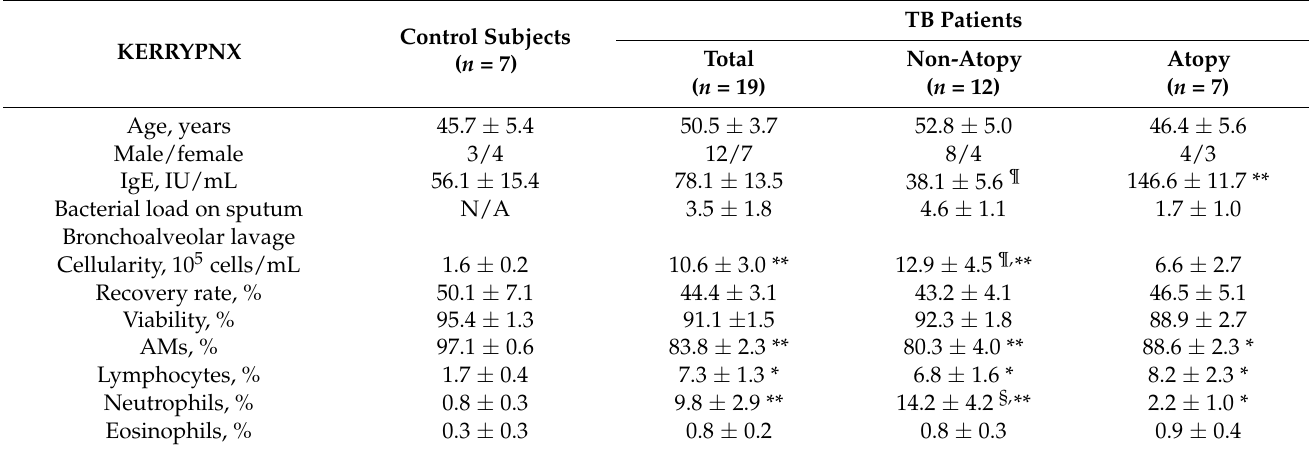
Table 1. Characteristics of bronchoalveolar lavage cells in control subjects and patients with active pulmonary TB. Control KERRYPNX